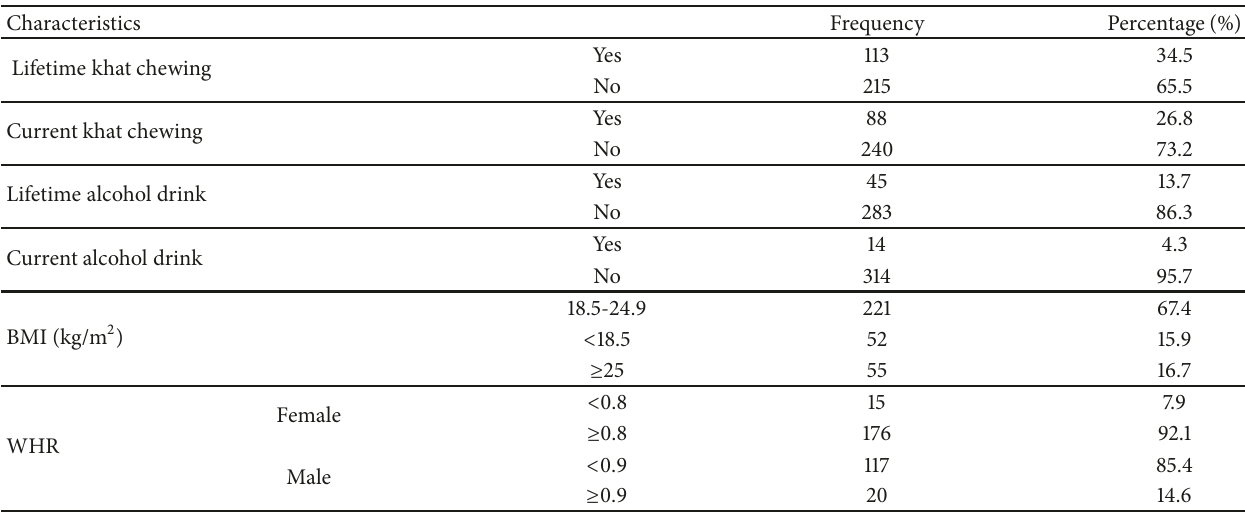
Table 2: Substance use and anthropometric characteristics of HIV-positive patients attending Jimma University Medical Center, Jimma, Ethiopia, 2018 (N = 328).